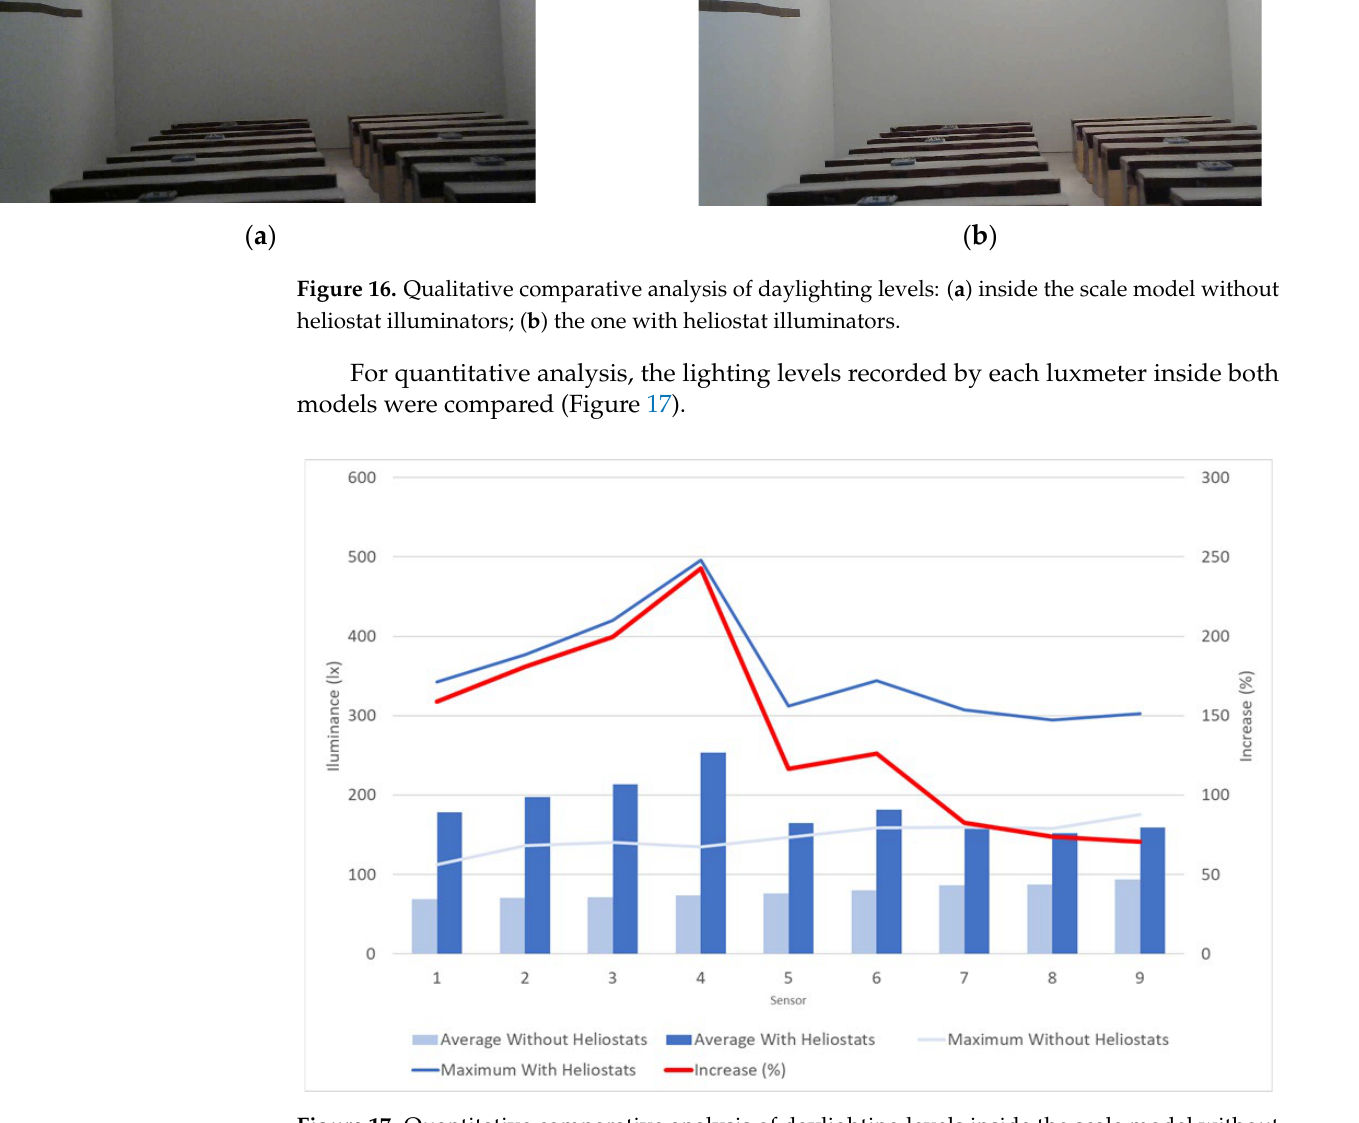
Figure 17. Quantitative comparative analysis of daylighting levels inside the scale model without heliostat illuminators and the one with heliostat illuminators.